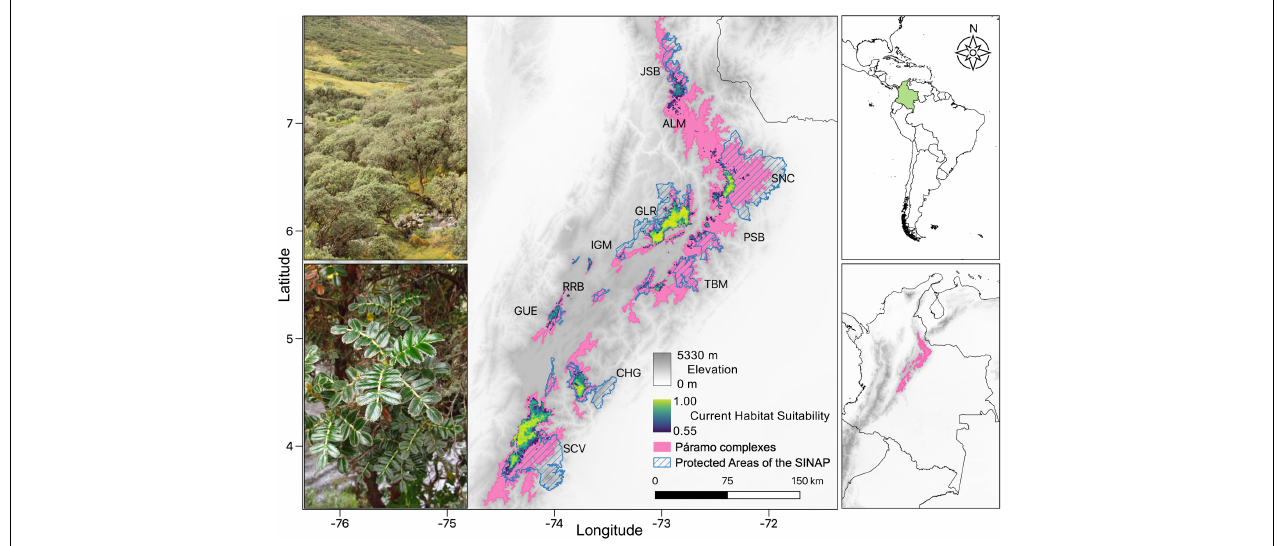
FIGURE 1 | Habitat and distribution of Polylepis quadrijuga woodlands in the Colombian Eastern Cordillera. Left panel: habitat and architecture of the P. quadrijuga (top) and morphology of the plant in situ (bottom; Photos by F. Fajardo). Central panel: Projection of the P. quadrijuga ensemble Habitat Suitability Model to current climatic conditions (showing suitability values > 0.554). Continuous color scale represents the habitat suitability scores. The pink shading denotes the spatial extent of the Páramo complexes along the Colombian Eastern Cordillera sensu IAvH (2012). The protected areas of the Colombian National System of Protected Areas (SINAP) that overlap with Páramo regions are represented by the diagonal blue-lined areas. Right panel: broad geographical context of the main map in South America (top) and Colombia political boundaries (bottom) including the Andes Cordilleras (gray) and Eastern Cordillera’s Paramo complex areas (pink).